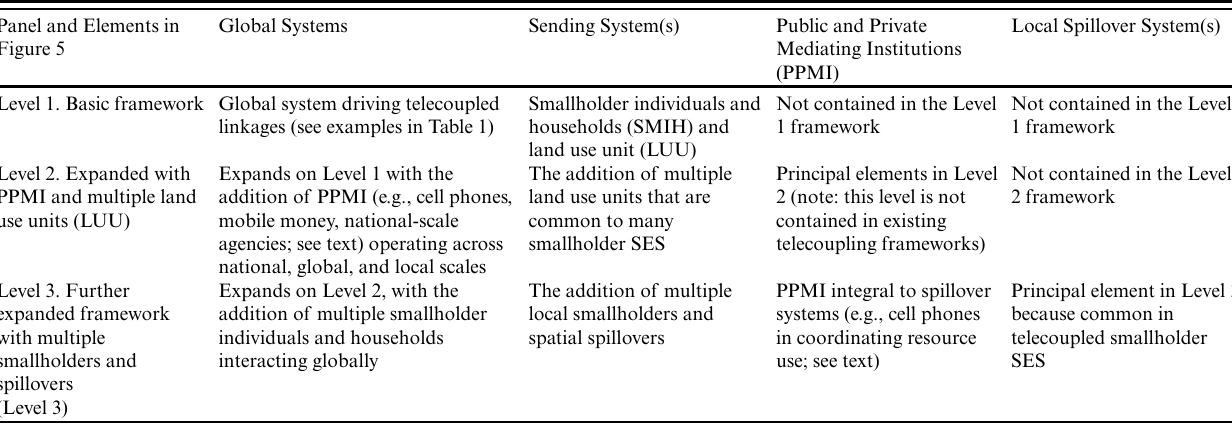
Table 3 . Multilevel elements of the framework of telecoupled smallholder social-ecological systems (SES; see also Fig. 5) Panel and Elements in Figure